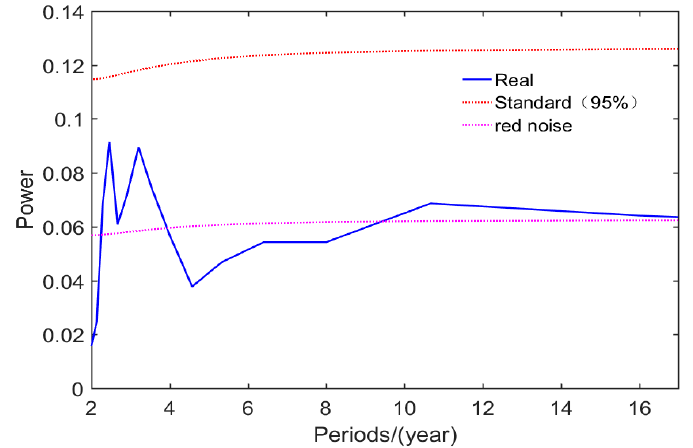
Figure 9. Estimations of EASMI power spectrums. The blue line indicates the power spectrum curve of EASMI and the dotted lines indicate the red and the white noise standard spectrum. The peak value of the power spectrum estimation between the red and white noise test lines passed the confidence test at the 0.05 level.